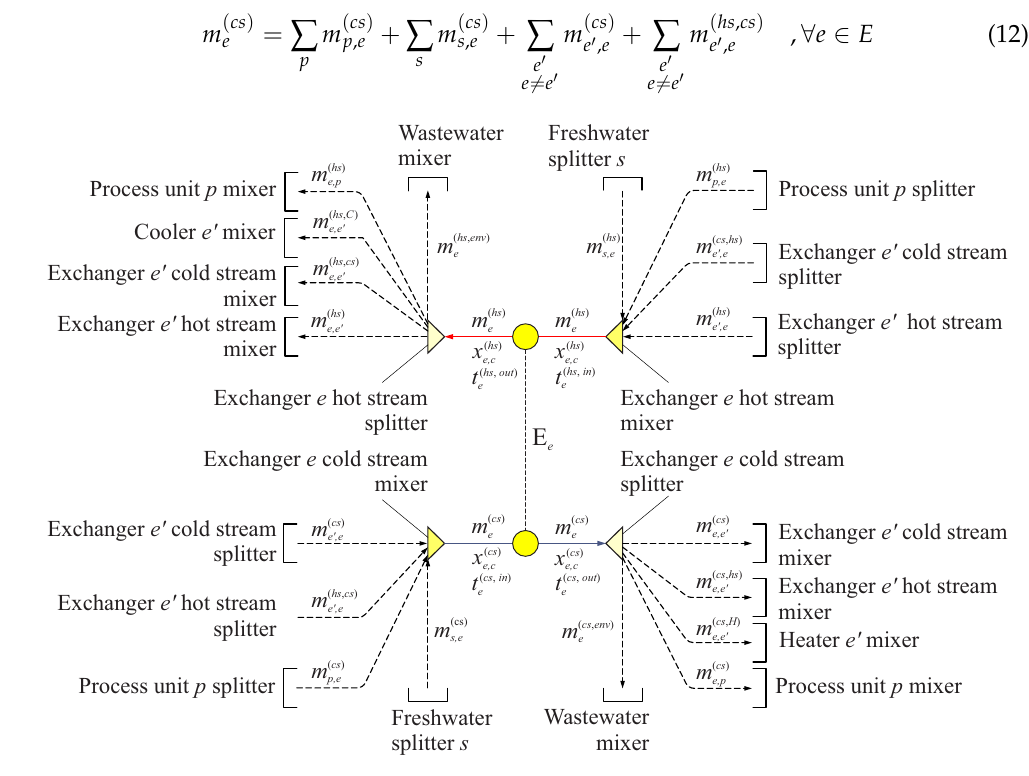
Figure 7. Heat exchanger unit with corresponding